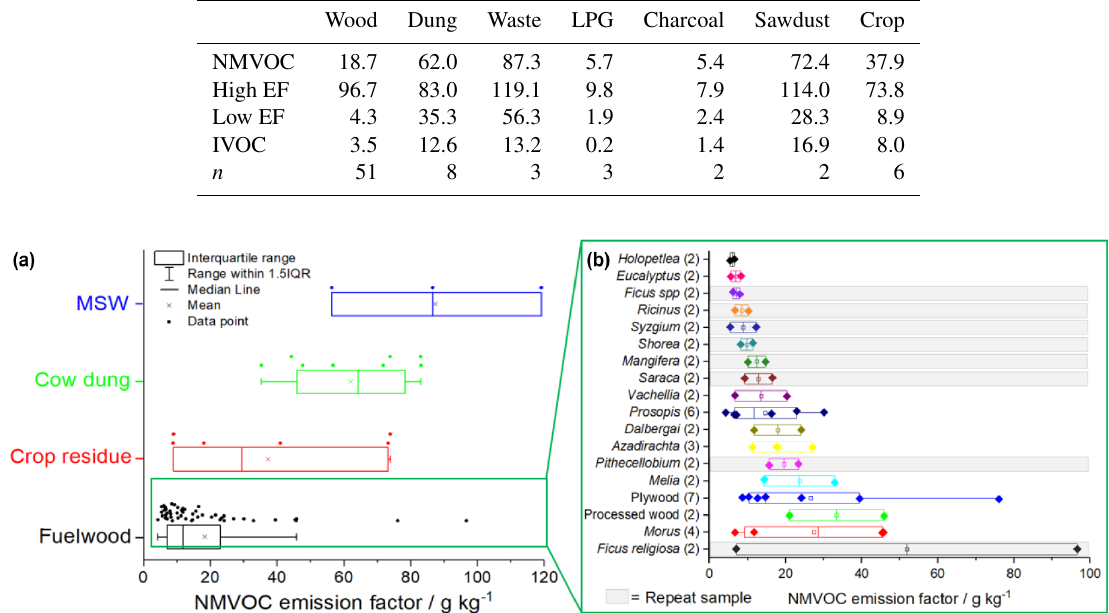
Figure 8. Variability in NMVOC emission factor by fuel type. (a) Range of emission factors measured for fuelwood, cow dung cake, crop residue and municipal solid waste samples with boxplots showing the mean, median, interquartile range and range within 1.5IQR and solid circles showing the spread of measured emission factors by fuel type. (b) Zoomed-in green region displaying range of NMVOC emission factors measured for individual species of fuelwood with the grey shaded region indicating repeat samples from the same sample collection location and diamonds indicating the measured NMVOC emission